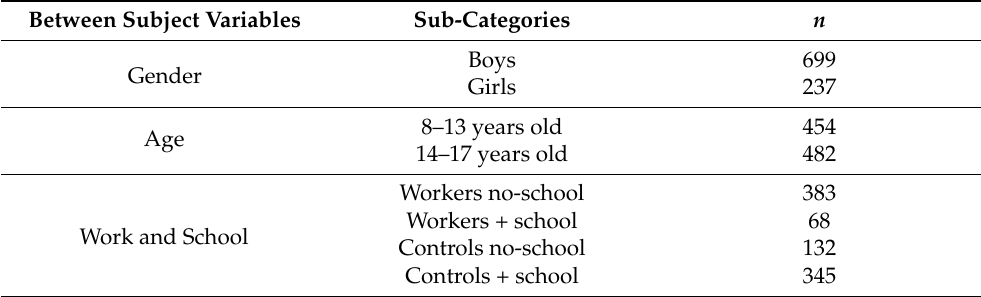
Table 1. Variables and